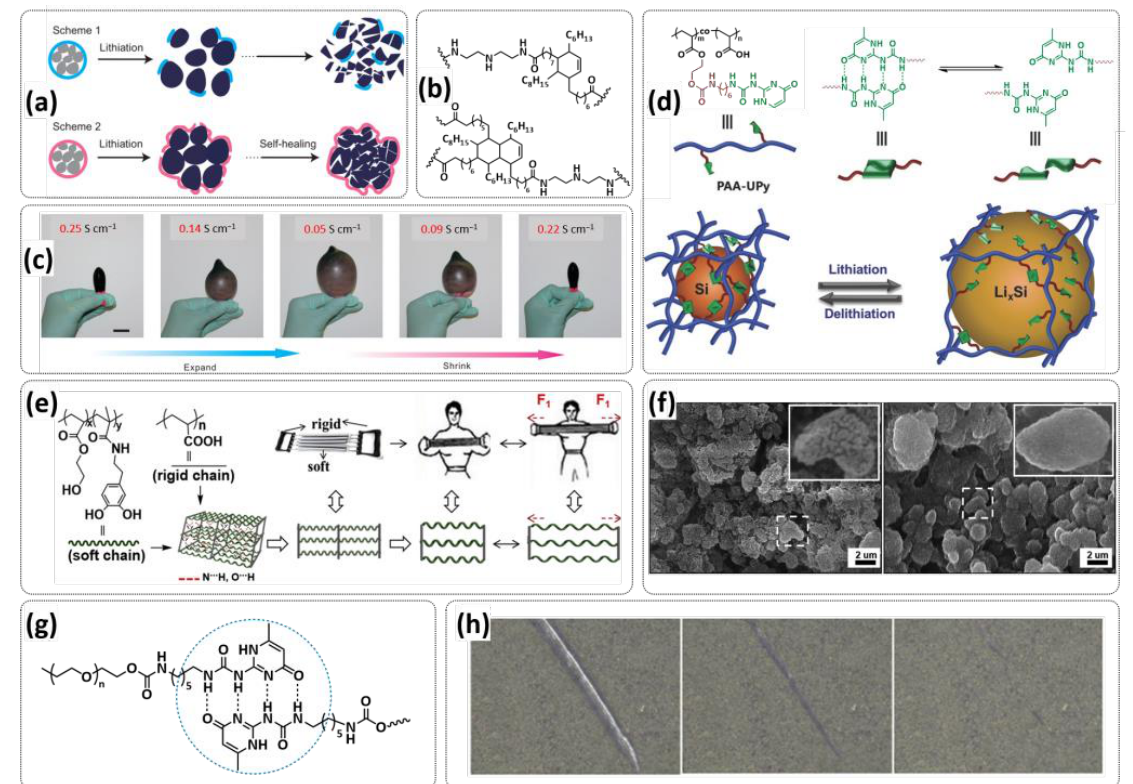
Figure 15. ( a ) Schematic illustration of the self-healing concept of polymer binder for Si anodes. ( b ) Chemical structure of the SHP binder. ( c ) The SHP/CB composite material was coated onto an inflatable balloon to mimic the volumetric changes of silicon particles over the cycling process. The changes in its electrical conductivity during the balloon’s repeated cycles of inflation and deflation were monitored. The SHP/CB coating remained conductive over the whole expand/shrink process.